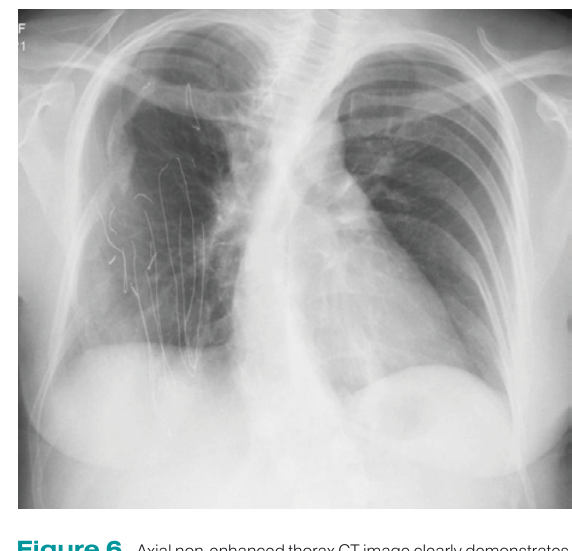
Figure 5. Posterior- anterior chest X-ray shows scoliosis and postoperative changes in the right lower ribs. Metastatic right paraaortic mass could not be differentiated in the image.